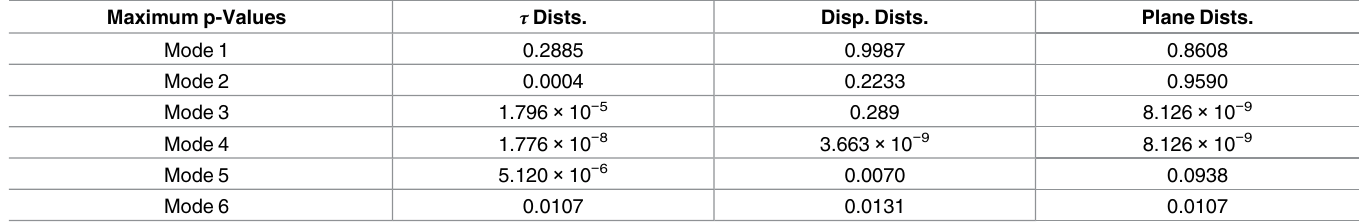
Maximum p-Values τ Dists. Disp. Dists. Plane